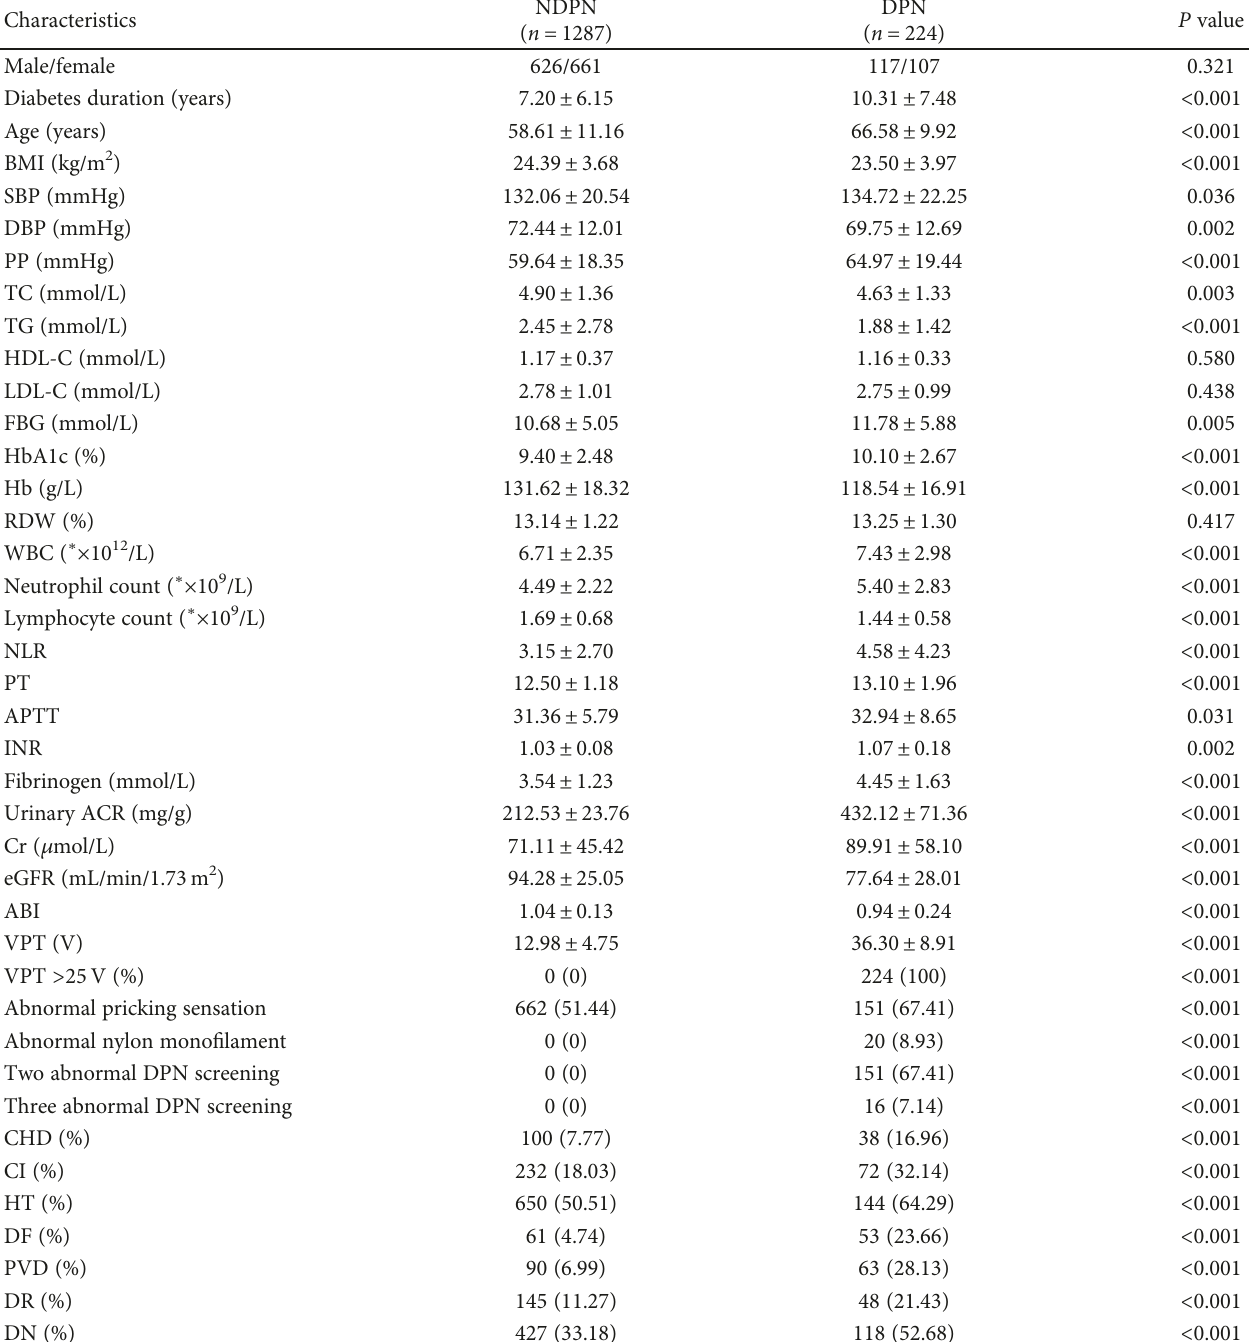
Table 1: Baseline characteristics of patients in NDPN and DPN